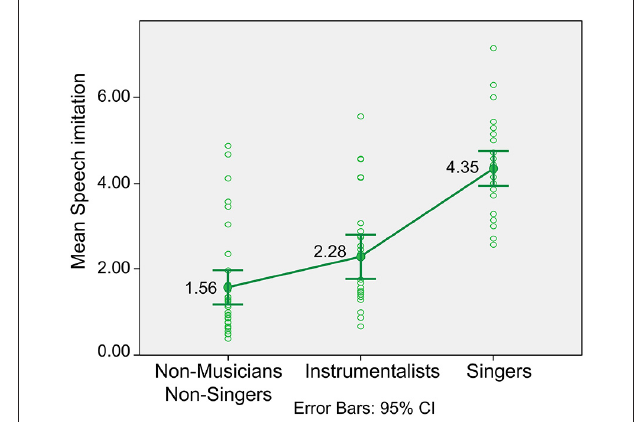
FIGURE 1 | ANOVA Hindi speech imitation. This figure shows the differences in the performance of Hindi of non-musicians/non-singers, instrumentalists and vocalists (singers). Instrumentalists were significantly better than non-musicians/non-singers but singers were significantly better compared to both, non-musicians/non-singers and